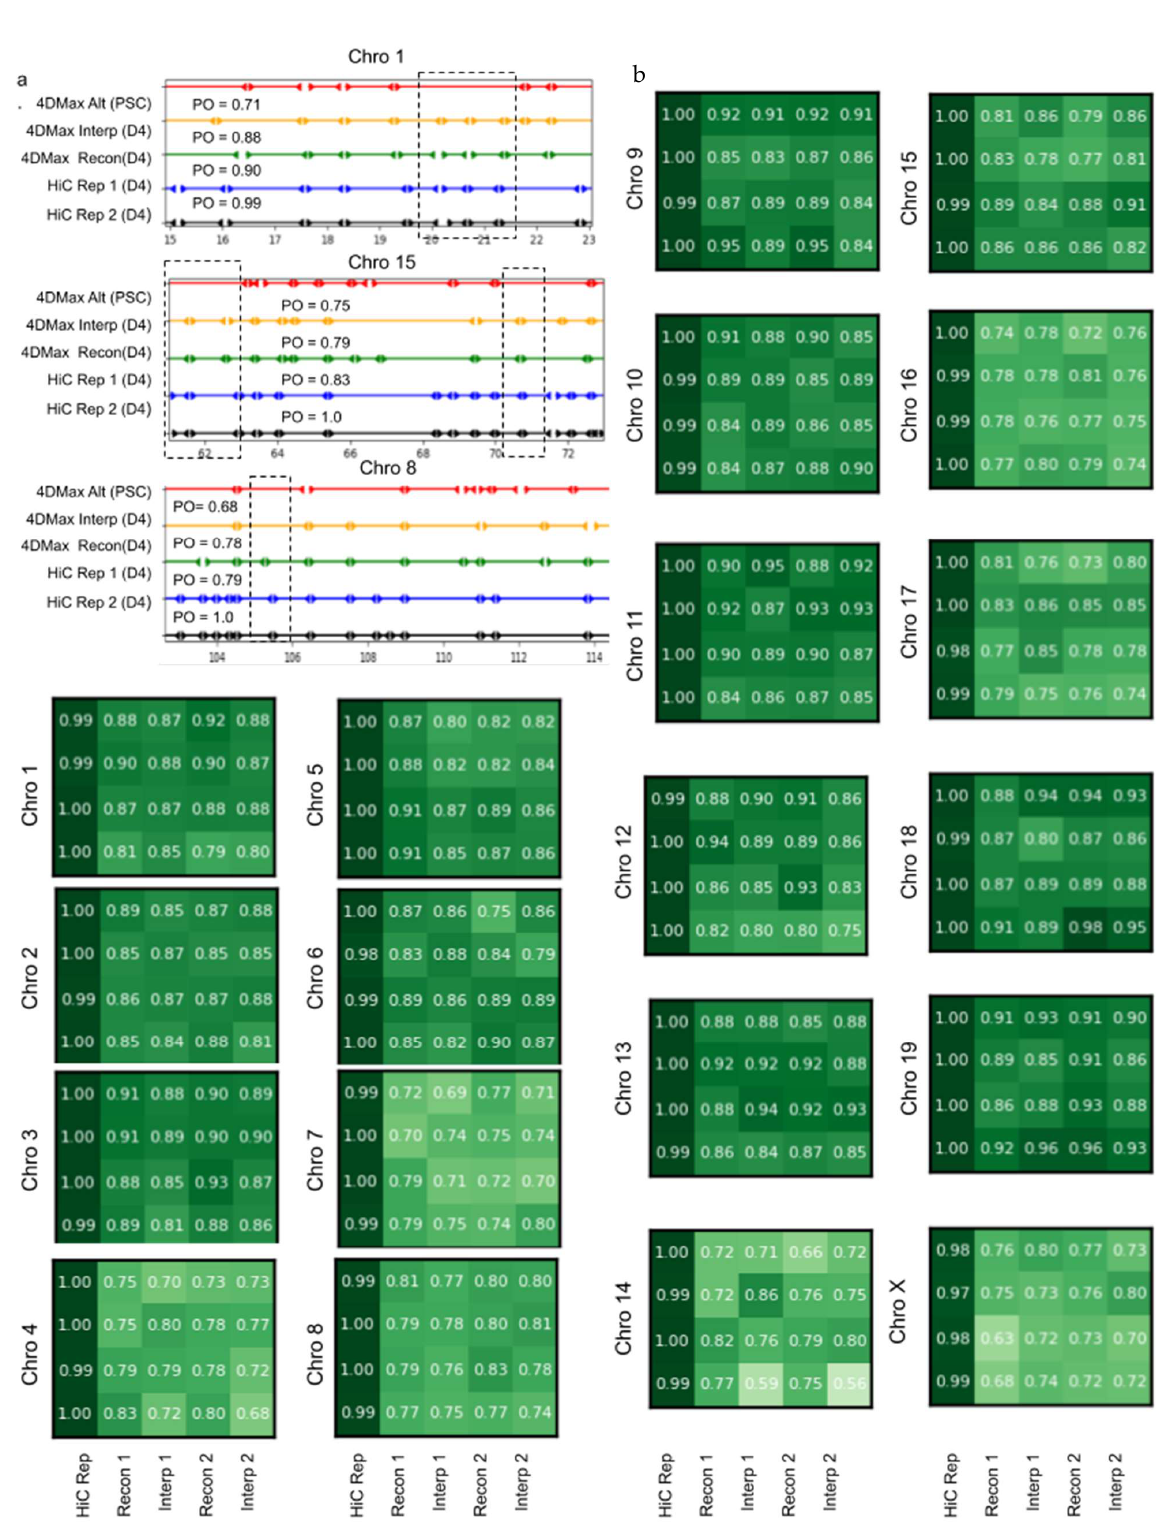
Figure 5. HiCTool identified topologically-associated domains. ( a ) Select images of TAD boundaries on (black) Real Hi-C replicate 1, (blue) Real Hi-C replicate 2, (green) 4DMax Reconstructed Map, (orange) 4DMax Interpolated Hi-C Map, and 4DMax Recon Map at a different time point. PO metric quantifies the percent of TAD boundaries found within 0.5 Mb of a boundary identified in Hi-C replicate 1. ( b ) PO of Interpolated and Reconstructed 4DMax TAD positions for both replicates across all chromosomes.